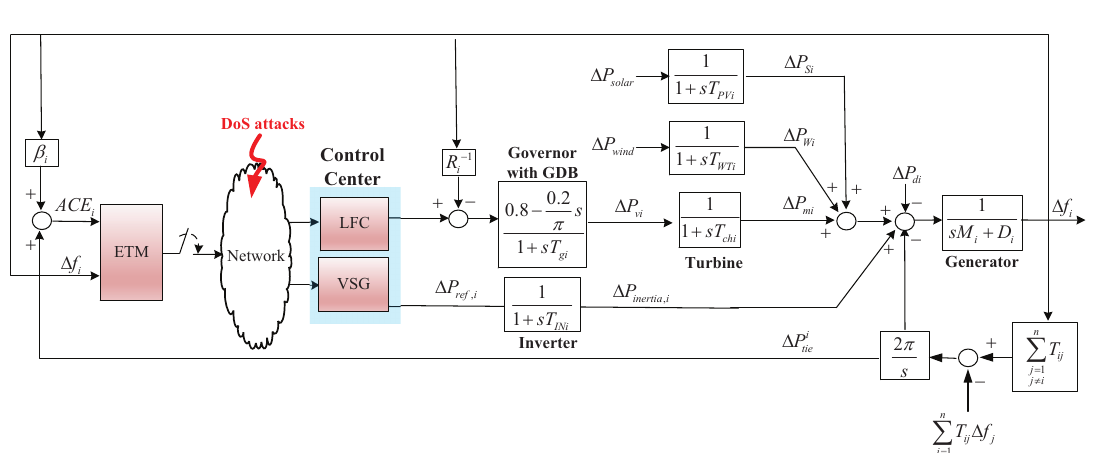
Figure 1. The i th area power system with event-triggered mechanism based LFC-VSG